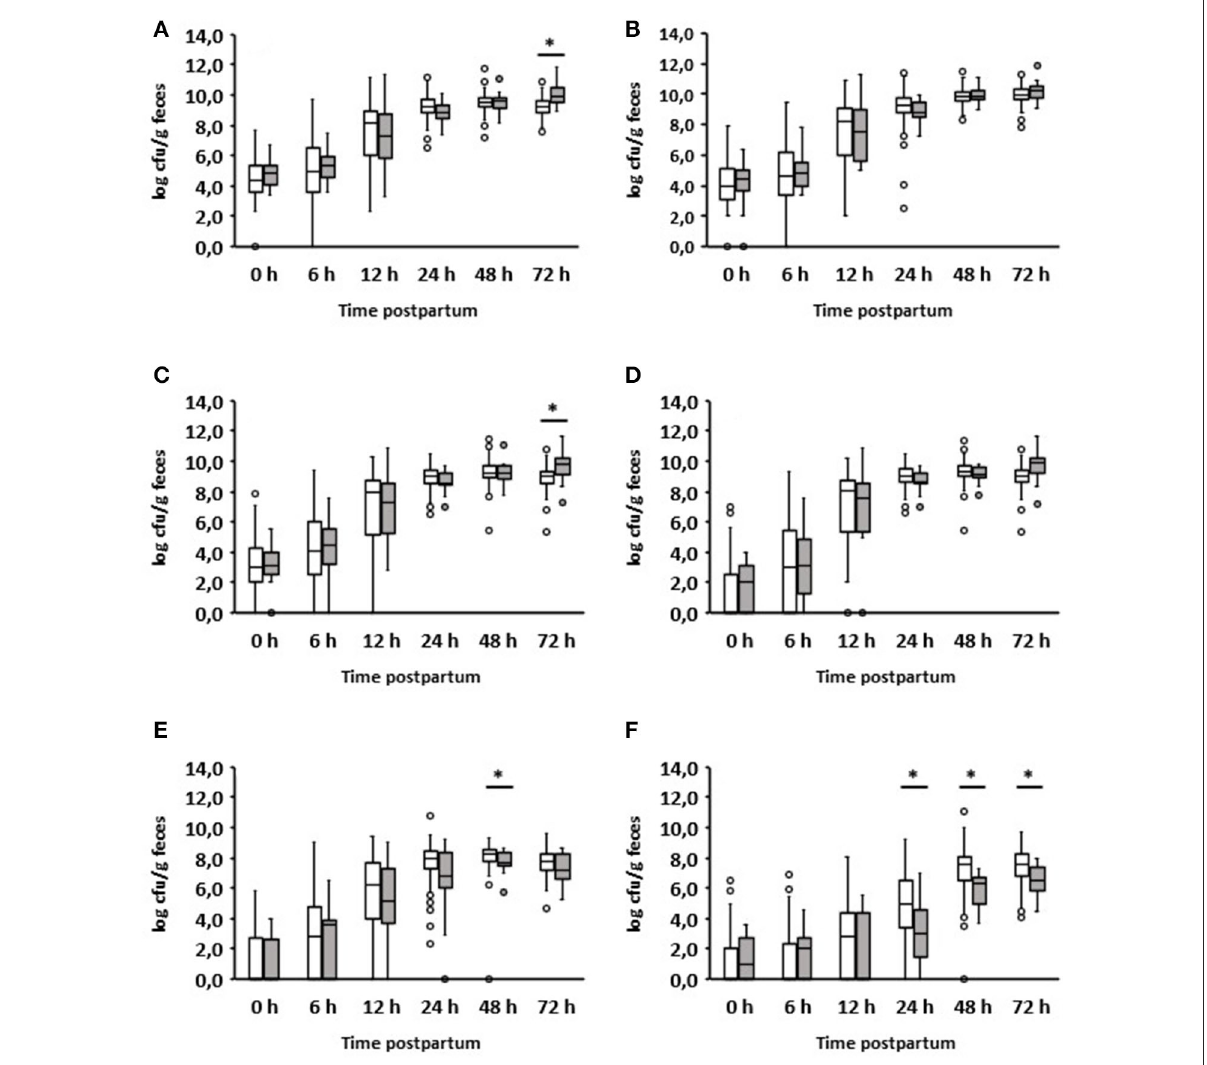
FIGURE3 Development of the fecal microbial contents of selected bacterial groups during the first 72h after birth. (A) Aerobic bacteria, (B) anaerobic bacteria, (C) Enterobacteriaceae , (D) E. coli , (E) Enterococcus spp., (F) Lactobacillus spp.; white boxes: values of healthy calves ( n = 134–128); gray boxes: values of calves with diarrhea onset on day 2 ( n = 16) (Wilcoxon test, * p <